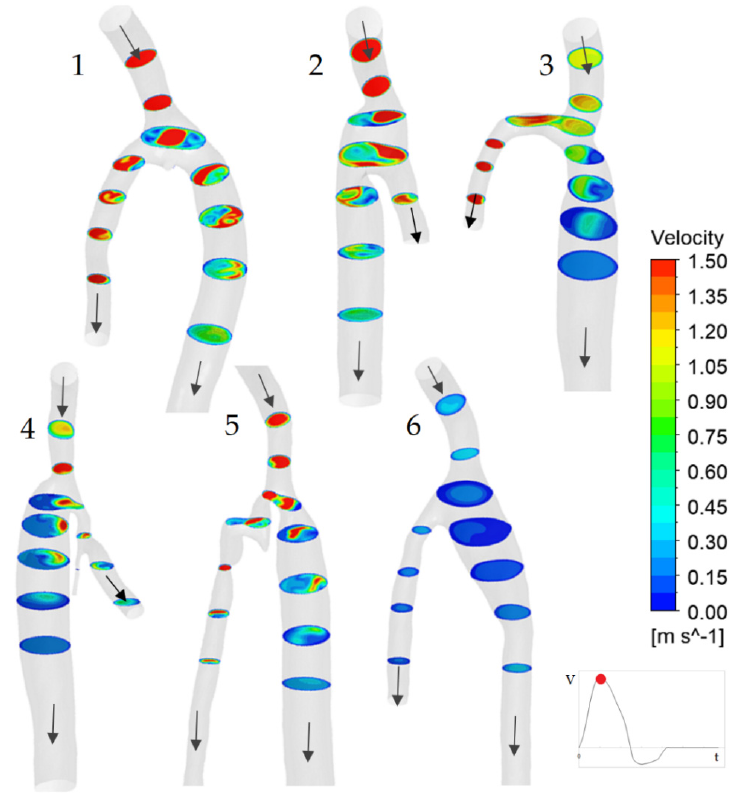
Figure 6. Velocity distributions in cross sections of six proximal anastomosis models at the instance of maximum flow. Arrows indicate the blood flow direction.